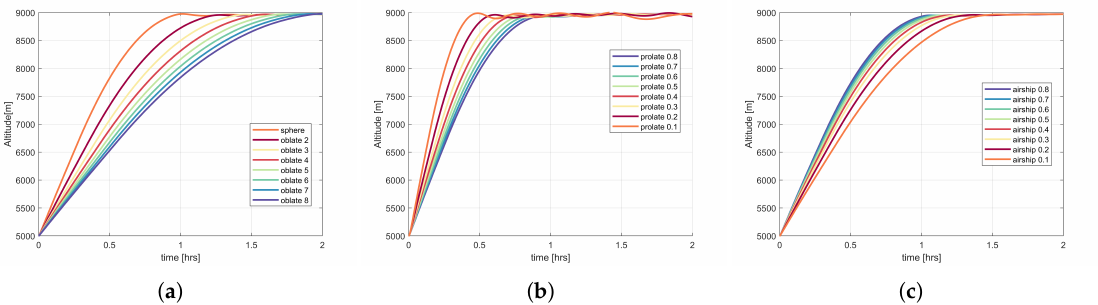
Figure 14. Altitude variation of the ZP balloons for different shapes with varying fineness ratios f in order to find the stable fineness ratio on Titan oblate ( a ) ( f : 2–8) ( b ) prolate (0.1–0.8) ( c ) airship (0.1–0.8).